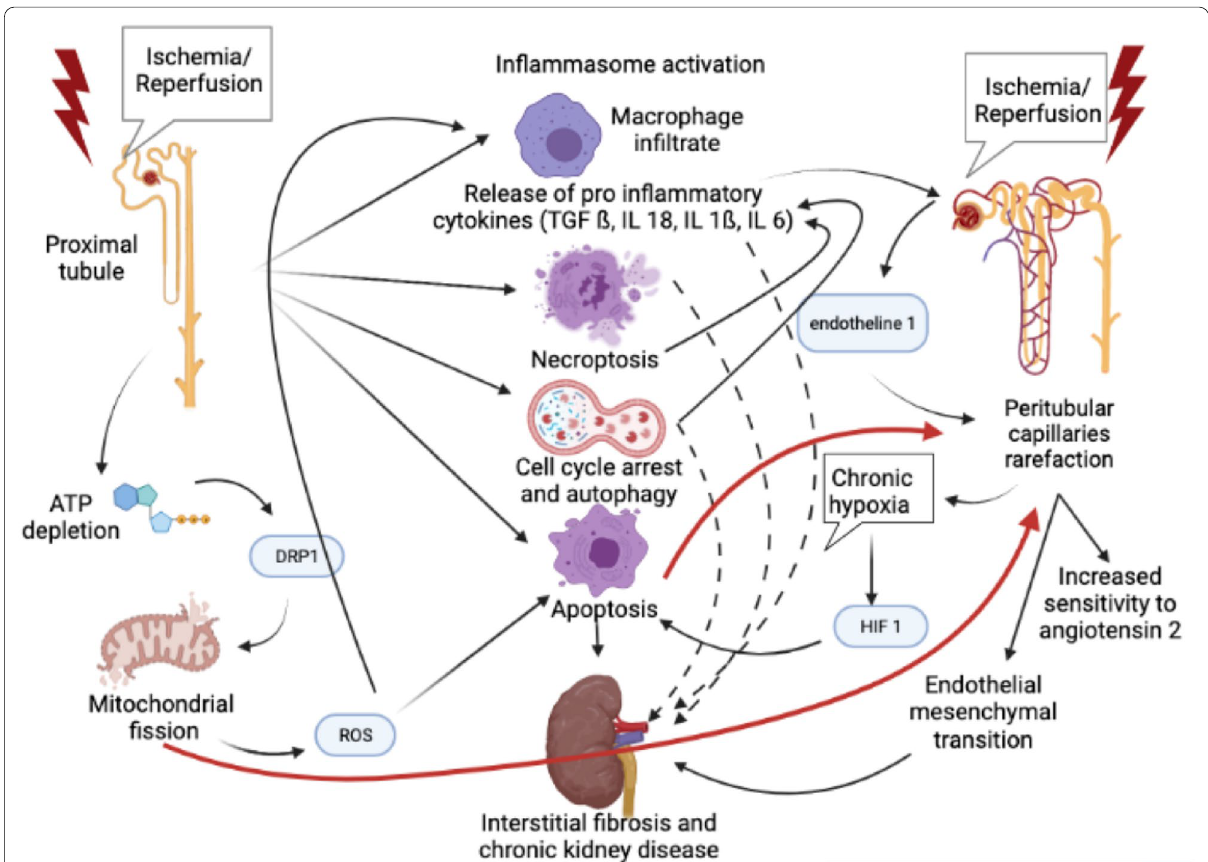
Fig. 4 Mechanisms underlying progression toward chronic kidney disease after